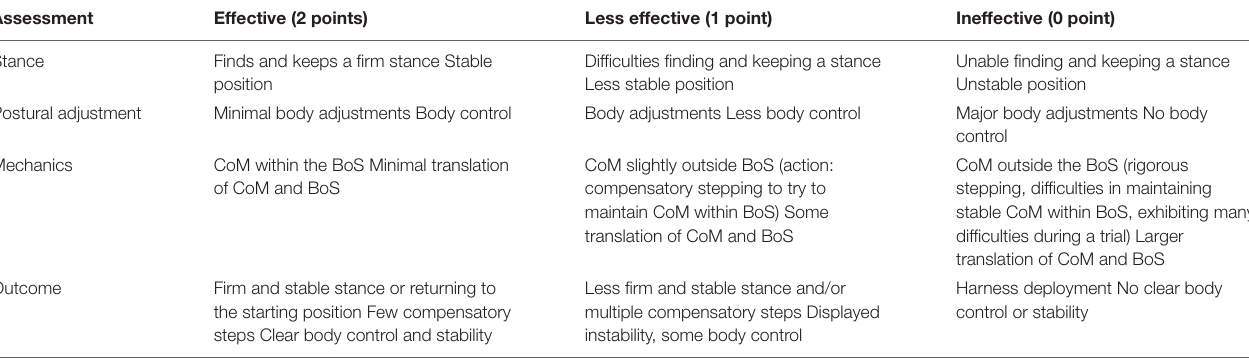
TABLE 4 | Grading table for balance recovery based on the characterization of strategy effectiveness.